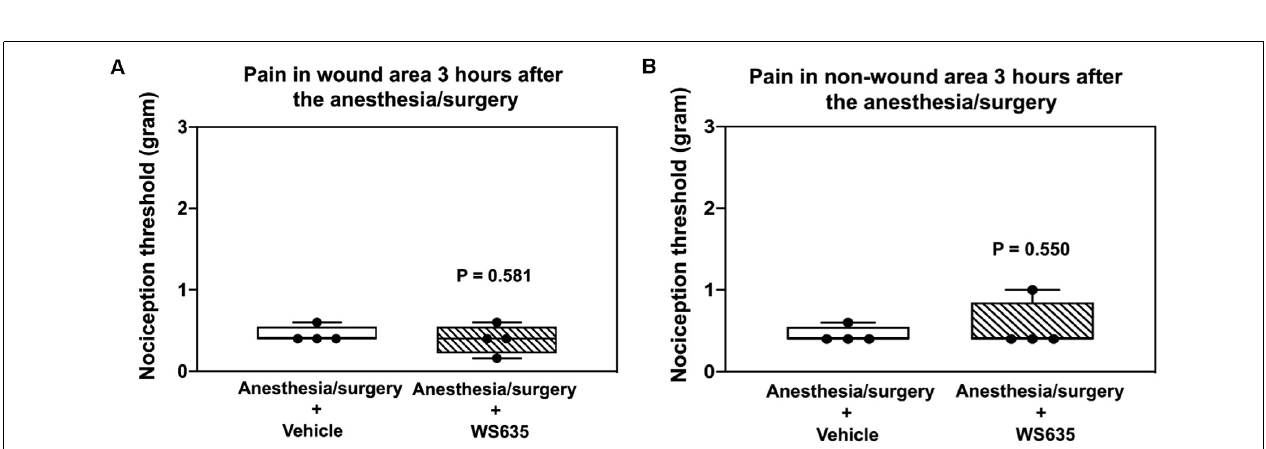
FIGURE 2 | Effects of WS635 on nociception threshold in mice after the anesthesia/surgery. Effects of WS635 and vehicle (corn oil) on the nociception threshold in the wound area (A) and non-wound area (B) in the mice following the anesthesia/surgery. WS635 did not significantly alter the nociception threshold compared to the vehicle in the mice following the anesthesia/surgery. N = 4 mice in each